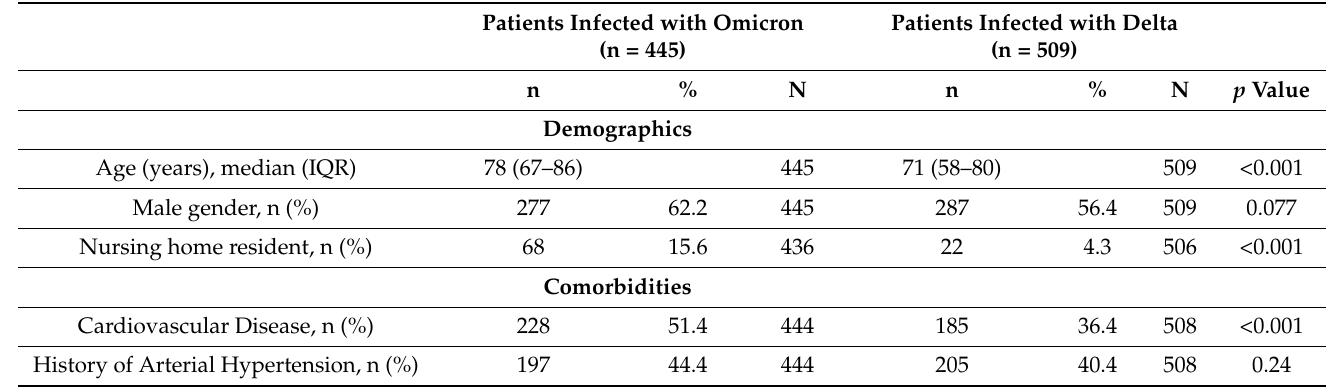
Figure 1. Flow chart of the study population selection within a multi-center matched cohort study to assess the impact of SARS-CoV-2 variants on COVID-19 disease severity among hospitalized patients admitted between 1 September 2021 and the 28 March 2022 in Belgium. Table 1. Patient characteristics by variant (Omicron and Delta) within a multi-center matched cohort study to assess the impact of SARS-CoV-2 variants on COVID-19 disease severity among hospitalized patients admitted between 1 September 2021 and the 28 March 2022 in